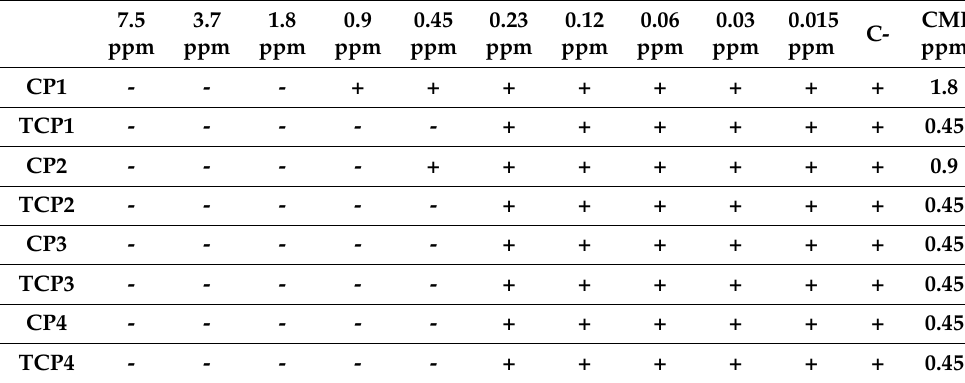
Table 4. MIC with direct CP and TCP technique on agar surface (4 yeasts). (+) Yeast growth on agar. (-) No growth of yeast on the